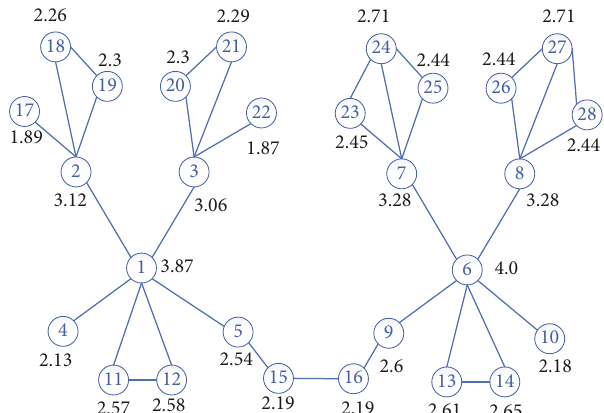
Figure 1: An example network consists of 28 nodes and 35